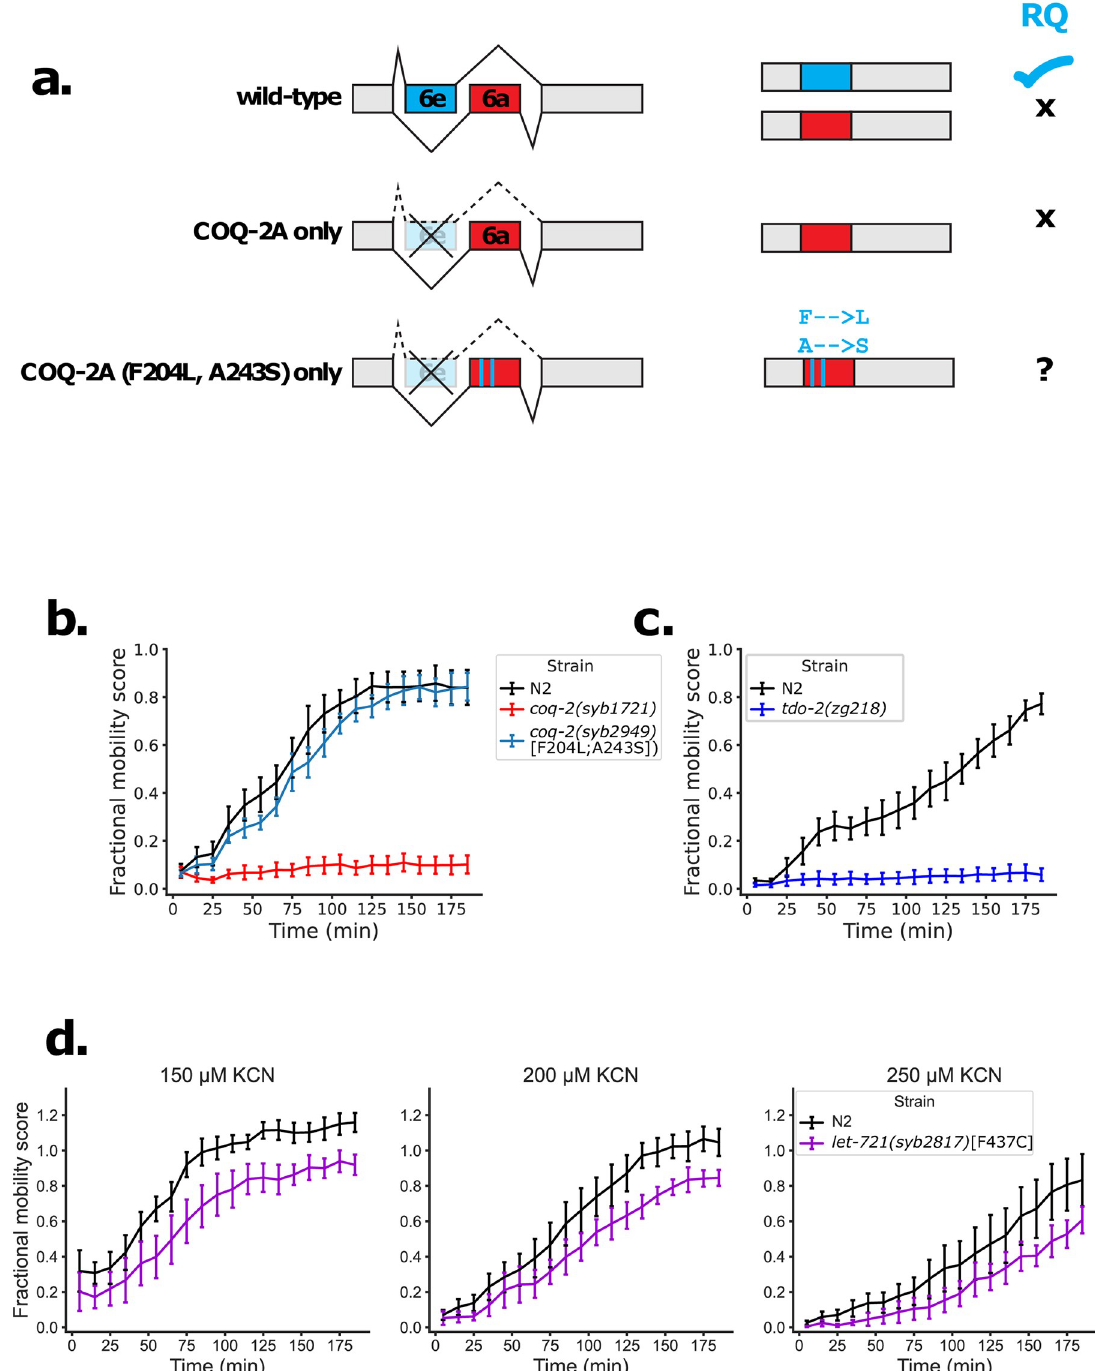
Fig 6. Mutations in STH-specific residues affect ability to survive extended KCN treatment. (a) Schematic of CRISPR-mediated engineering of a COQ-2 mutant. coq-2 exons 6a and 6e are alternatively spliced in a mutually exclusive manner in wild-type worms. Mutant worms with exon 6e deleted ( coq-2 Δ 6e ) are unable to synthesise RQ. Exon 6e contains 2 helminth-specific residues and mutations were generated in the coq-2 Δ 6e mutant, such that two residues in exon 6a are replaced with their helminth-specific counterparts (F204L, A243S). (b) Helminth-specific residues in COQ-2 are required for survival in KCN. L1 worms were treated with 200 μ M KCN for 15 h followed by a 6-fold dilution, and worm movement was tracked for 3 h. The RQ-deficient coq-2 Δ 6e mutant cannot survive extended KCN treatment while the coq-2 Δ 6e F204L;A243S mutant ( coq-2a(syb2949);coq-2e(syb1721) ) can now recover from KCN treatment, suggesting restored ability to synthesise RQ. (c) The TDO-2 PLD loop is required for survival in KCN. Wild-type (N2, black) or tdo-2(zg218) mutant worms (blue) L1 worms were treated with 200 μ M KCN for 15 h followed by a 6-fold dilution, and worm movement was tracked for 3